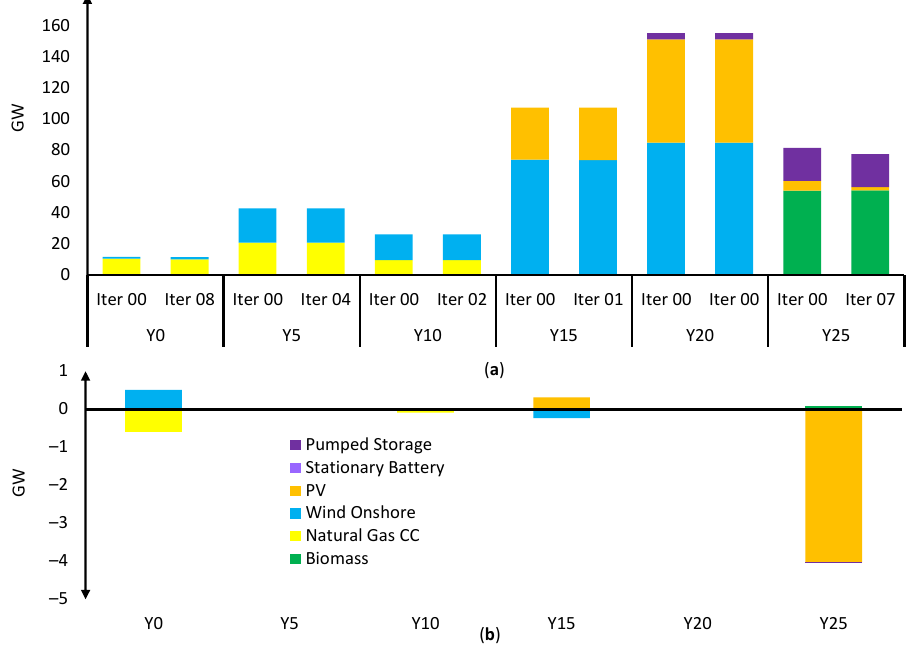
Figure 8. Change of endogenous investment over iterations (myopic): ( a ) technology mix for iteration 0 and the last iteration in each year; ( b ) delta between iteration 0 and last iteration per year and technology.